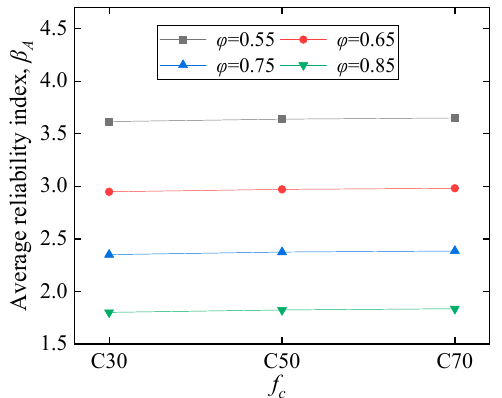
Figure 12. Concrete strength effects.